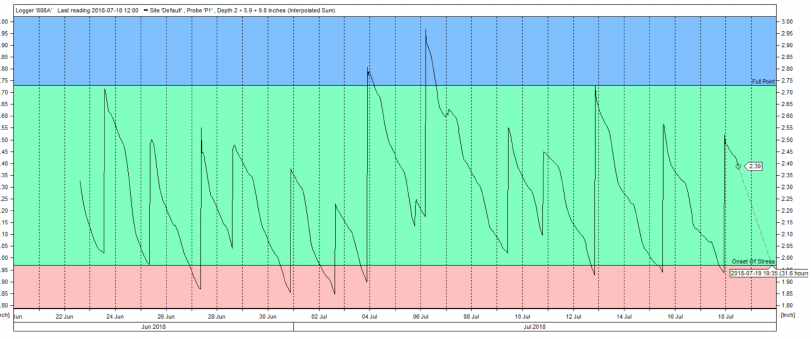
Figure 2. A screenshot of one soil moisture sensor Sentek Data Explorer showing the dynamics of average soil profile water storage during a part of June–July period. The scale of the profile water storage is inches and should be multiply by 25.4 for the conversion into mm.